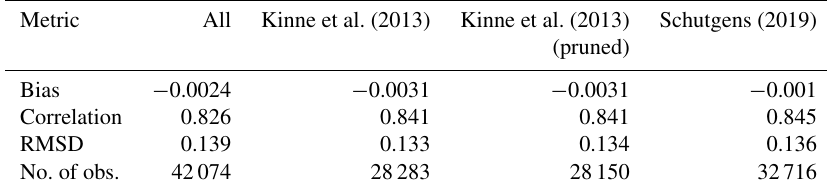
Table 4. Averaged product evaluation with AERONET depending on the selection of AERONET sites used as truth reference.